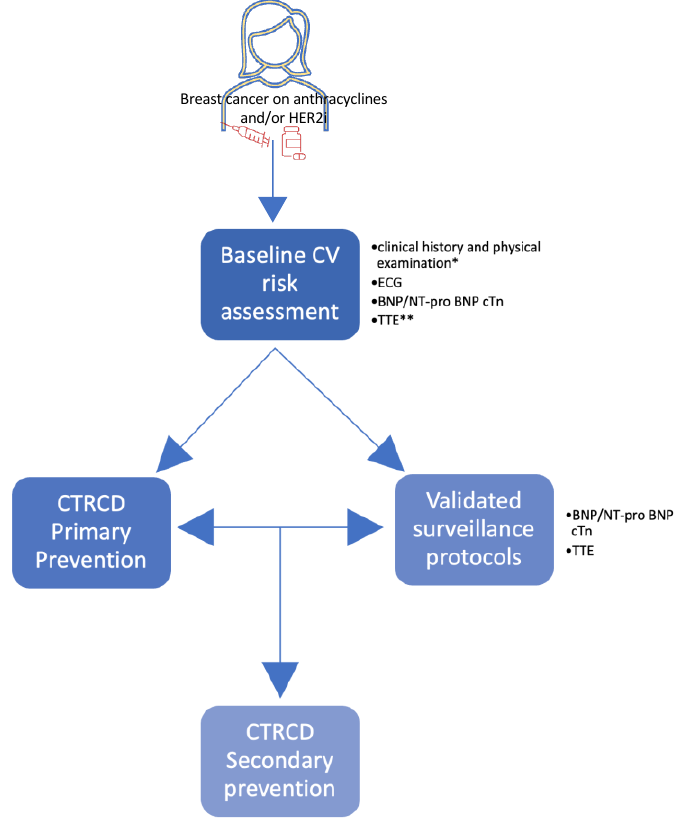
Figure 2. A stepwise multidisciplinary approach to management of cardiotoxicity in breast cancer patients undergoing anthracycline and/or HER2i treatment. * Including vital sign measurements, general blood tests including fasting plasma glucose/HbA1c, kidney function, and lipid profile. ** In selected cases. Consider other CV complementary tests in selected patients: cardiac magnetic resonance (CMR), coronary computed tomography angiography (CCTA), or cardiopulmonary exer- cise testing (CPET). Abbreviations: BNP, B-type natriuretic peptide; cTn, cardiac troponins; CTRCD, cancer-therapeutics-related cardiac dysfunction; HER2i, HER2 inhibitors; NT-proBNP, N-terminal pro B-type natriuretic peptide; TTE, transthoracic